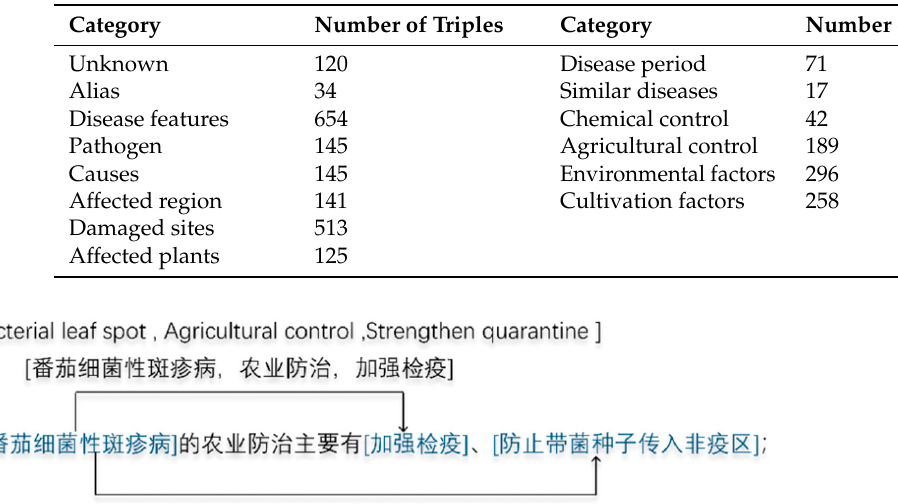
Table 2. Relation categories.